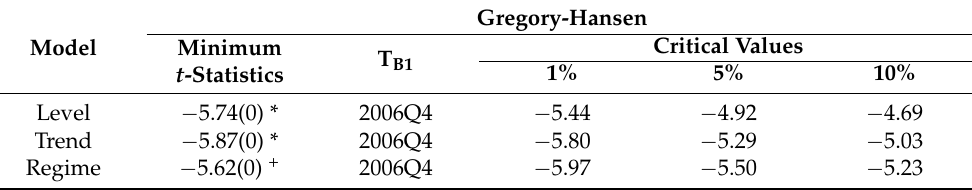
Table 7. Cointegration test with one break.